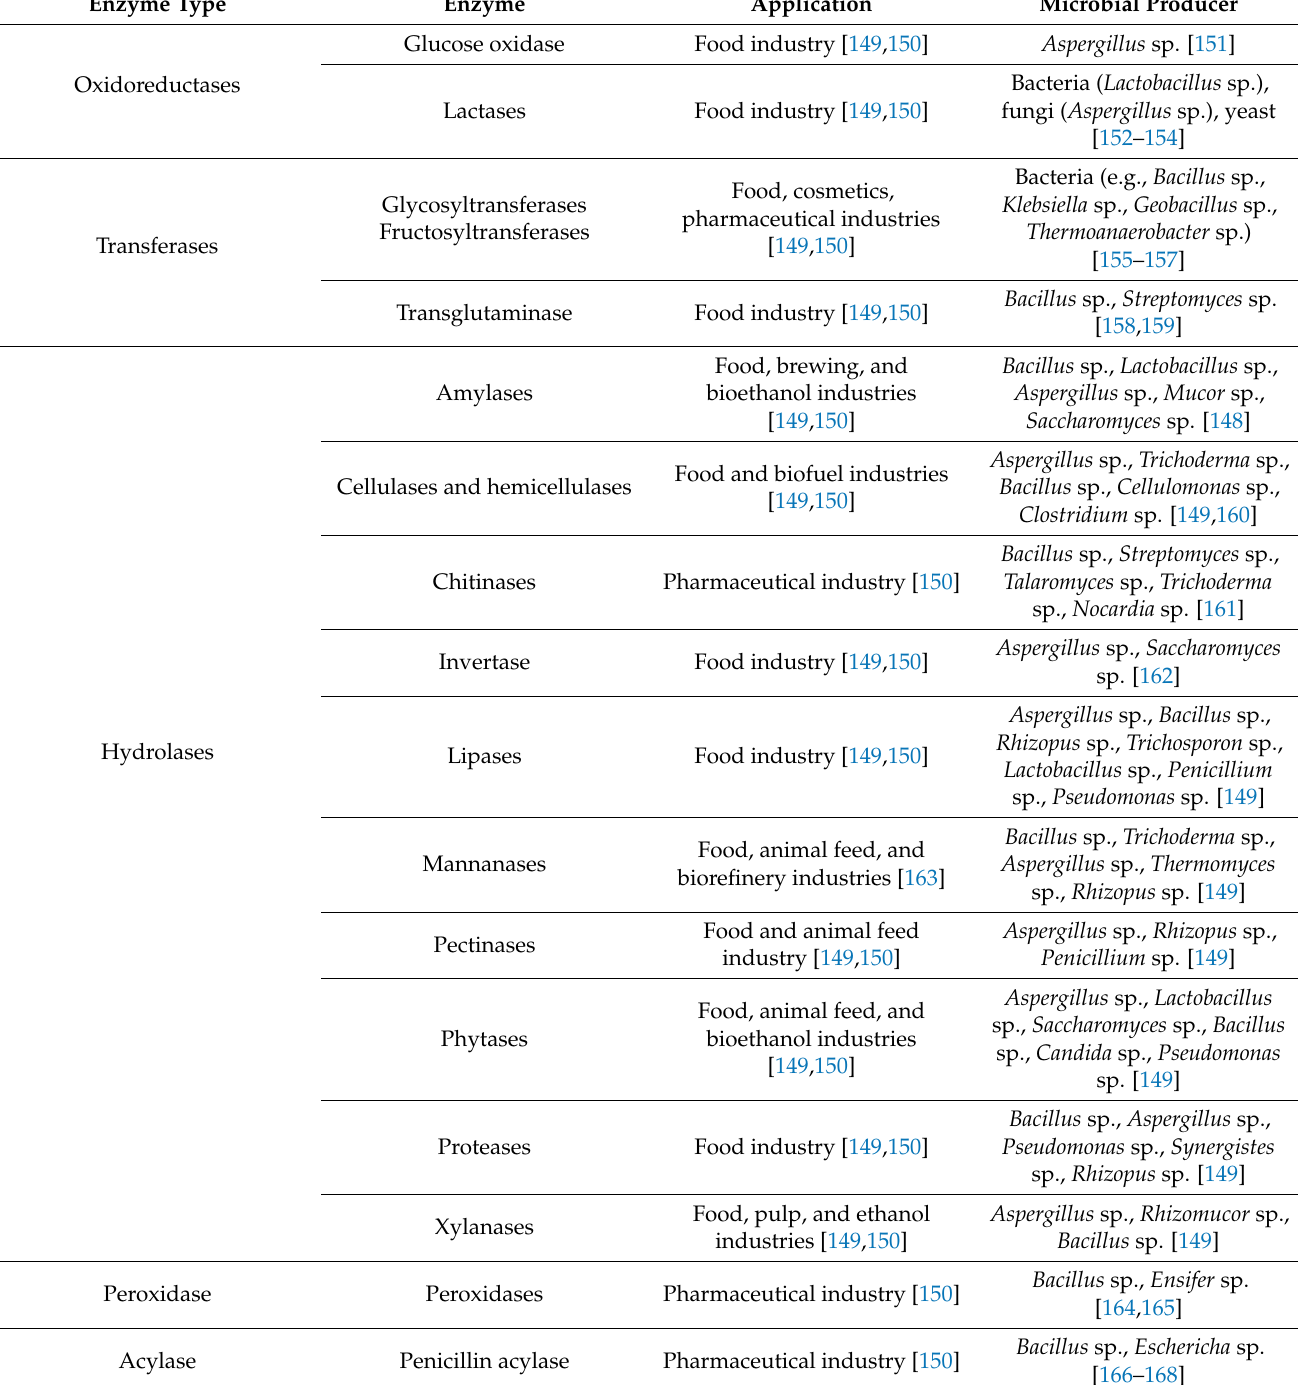
Table 3. Examples of industrial enzymes and the microbial producers. Reconstructed from Ventura-Sobreville et al.,